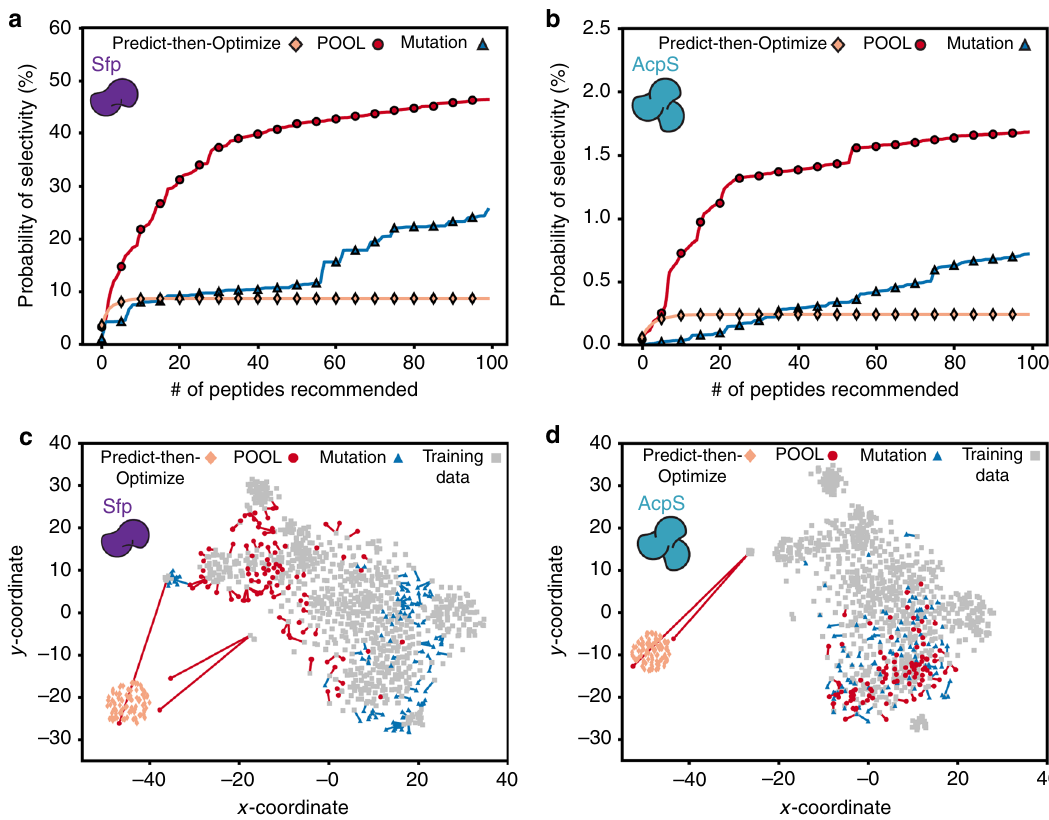
Fig. 3 Simulated method performance comparison and peptide diversity evaluation. A comparison between the POOL (red circle), mutation (blue triangle), and predict-then optimize (pale orange diamond) methods for Sfp ( a ) and AcpS ( b ) based on a simulation of 100 peptides recommended after observing results from two rounds, and evaluated using four rounds of data. Peptide homology in peptide space for Sfp ( c ) and AcpS ( d ) is shown for each of the methods POOL (red circle), mutation (blue triangle), predict-then-optimize (pale orange diamond) and overlaid with the peptide training data (gray square). Distances between points represents how similar or dissimilar the corresponding peptides are from each other. A line from each peptide recommended by POOL and mutation indicates the closest peptide in the training